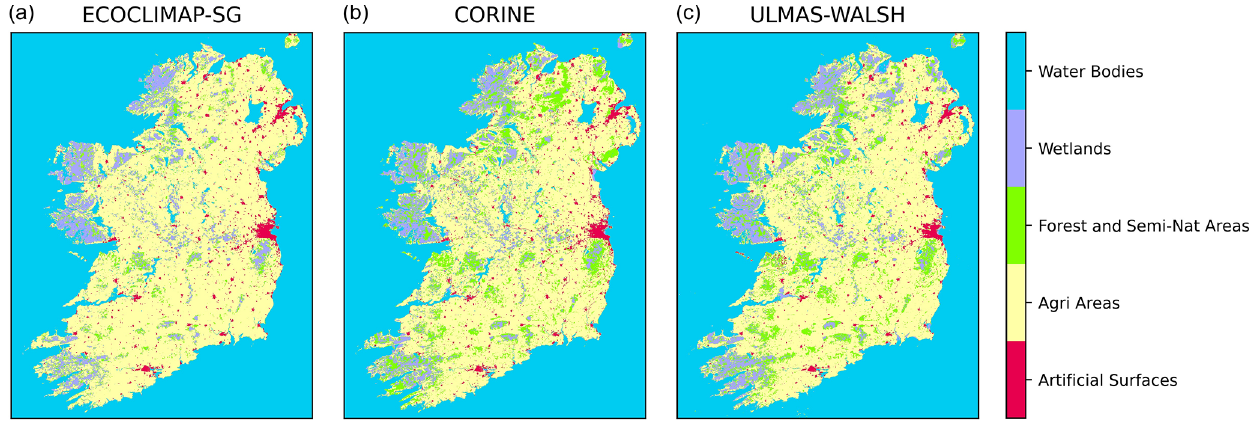
Figure 4. Land-cover maps of Ireland: ECO-SG (a) , CORINE (b) and the UW map (c) . Pixel-wise, ECO-SG was found to be 89.9% similar to CORINE. The UW map was found to be 92.5% similar to